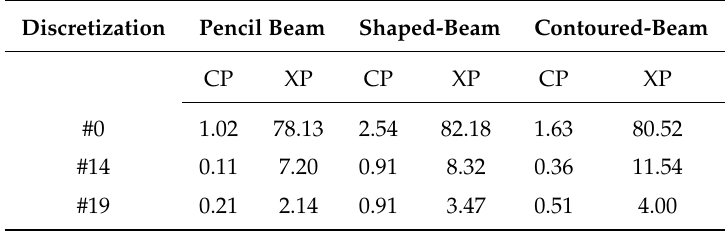
Table 4. Cumulative relative errors (%) in the prediction of the three radiation patterns using different SVR models for the copolar (CP) and crosspolar (XP)